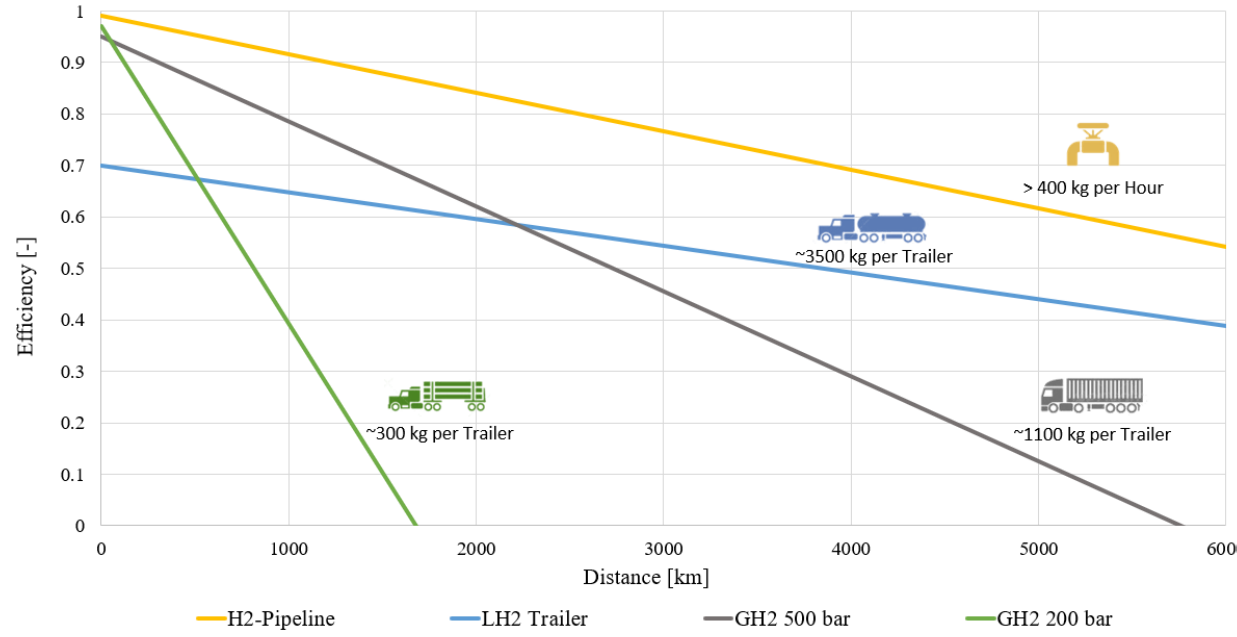
Figure 13. Transport efficiencies of different H 2 distribution technologies.